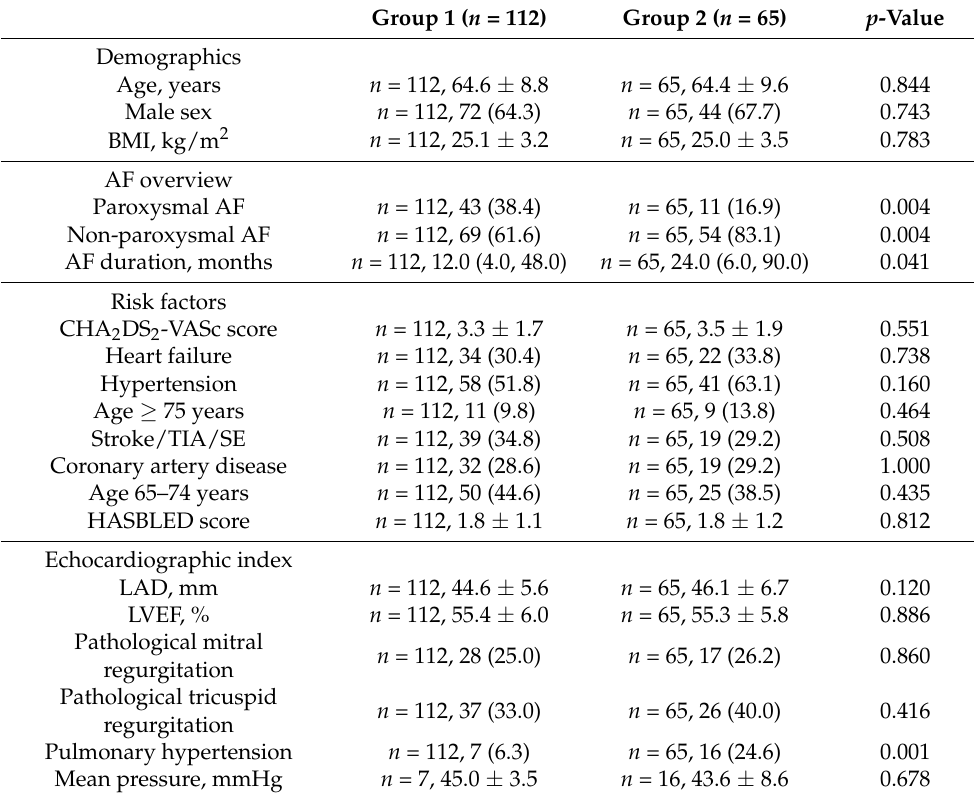
Table 1. Baseline